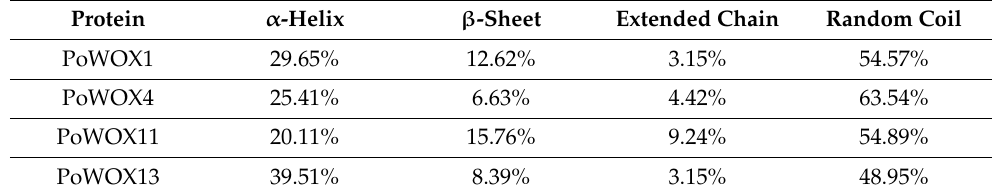
Table 7. Predicted secondary structure of PoWOX proteins.